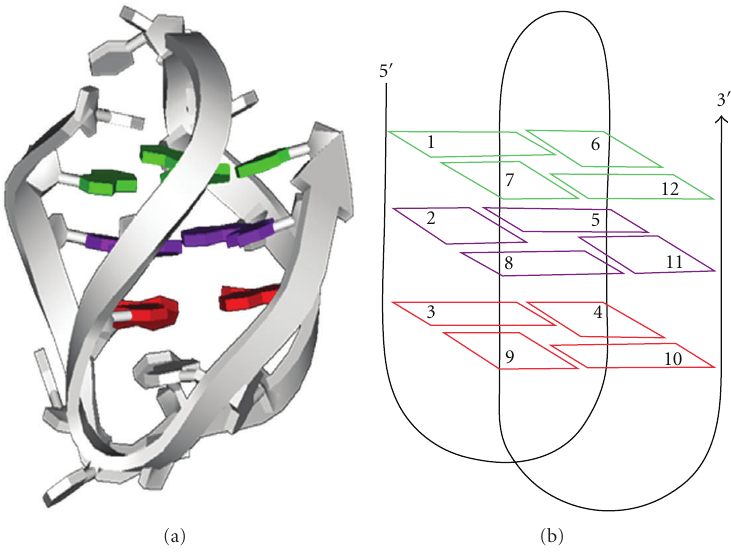
Figure 1: (a) Structure of human telomere (5 (cid:2) -A(G 3 T 2 A) 3 G 3 -3 (cid:2) ) G-quadruplex in the presence of Na + (PDB ID: 143D). (b) Schematic illustration of G-quadruplex AP-0 with a top G-quartet plane (green), middle G-quartet plane (purple), and bottom G-quartet plane (red). The numbers indicate the position of abasic sites (AP- X ( X indicates 1 to 11)).